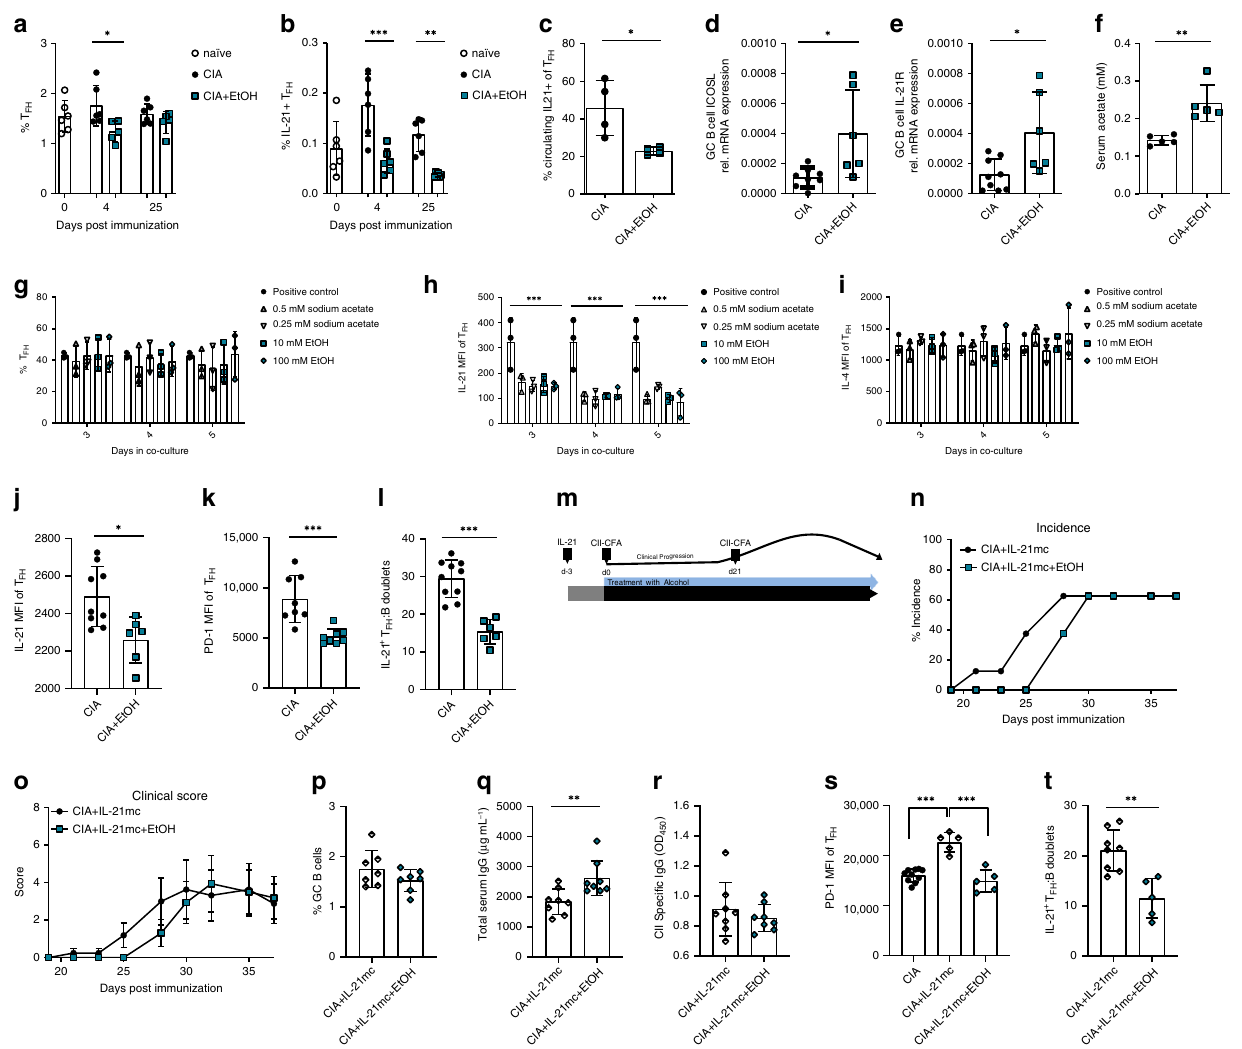
Fig. 5 Alcohol exposure suppresses T FH cell response. Flow cytometric analysis of splenic a T FH and b IL-21 producing T FH cells in naïve mice, CIA mice exposed to vehicle (CIA) or alcohol (CIA + EtOH) ( n = 6 mice per group) c Percentage of IL-21 producing circulating T FH cells at 28 dpi in peripheral blood of the two treatment groups ( n = 4 mice per group). d ICOSL and e IL-21R gene expression in sorted GC B cells in the two treatment groups (CIA, n = 10 mice, CIA + EtOH, n = 6 mice). f Serum acetate concentrations at 42 dpi ( n = 5 mice per group). g Percentage of T FH cells, h IL-21 MFI and i IL-4 MFI of T FH cells in in vitro differentiation ( g – i three independent experiments, n = 1 per experiment, three technical repeats). j IL-21 MFI (CIA, n = 10 mice, CIA + EtOH, n = 6 mice) and k PD-1 MFI of T FH cells in CIA and CIA + EtOH mice ( n = 8 mice per group). l Flow cytometry analysis of IL-21 producing T FH :B cell conjugates in CIA ( n = 10 mice) and CIA + EtOH mice ( n = 6 mice) expressed as percent of all T FH :B conjugates. m Experimental design of IL-21 overexpression in CIA model. n Incidence and o clinical score of arthritis in CIA mice treated with IL-21 minicircle DNA without (CIA + IL-21mc) and with alcohol exposure (CIA + IL-21mc + EtOH) ( n = 8 mice per group). p Flow cytometry analysis of GC B cells CIA + IL-21mcCIA + IL-21mc + EtOH mice ( n = 7